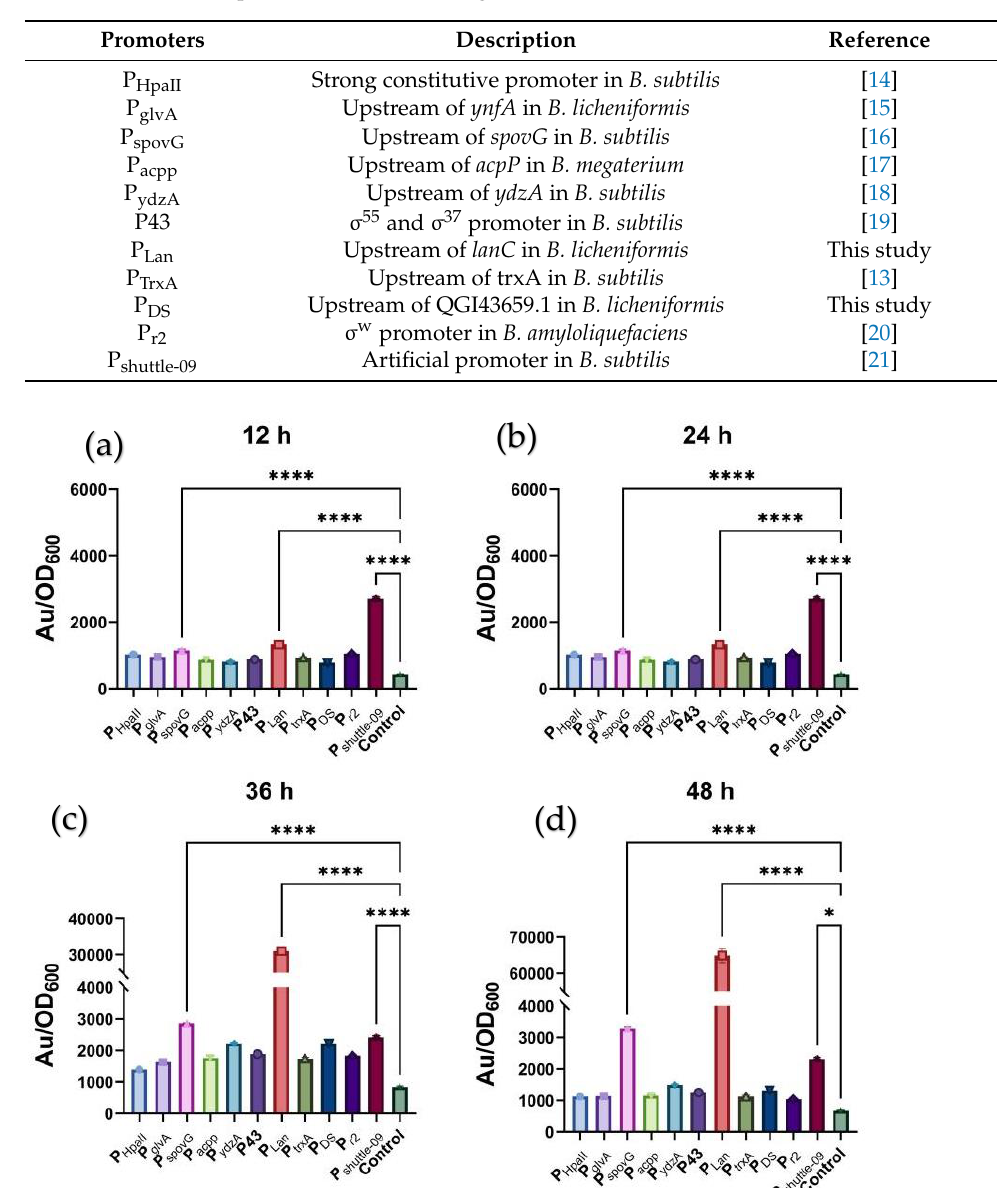
Figure 1. The strength and the trends over cultivation time of the selected promoters, characterized by the fluorescent method. ( a ) Relative fluorescence intensity at 12 h, ( b ) relative fluorescence intensity at 24 h, ( c ) relative fluorescence intensity at 36 h, ( d ) relative fluorescence intensity at 48 h. Au—Arbitrary unit. Results are expressed as mean of replicates. Columns with **** or * represent statistically significant differences between groups at p < 0.0001 or p < 0.05,